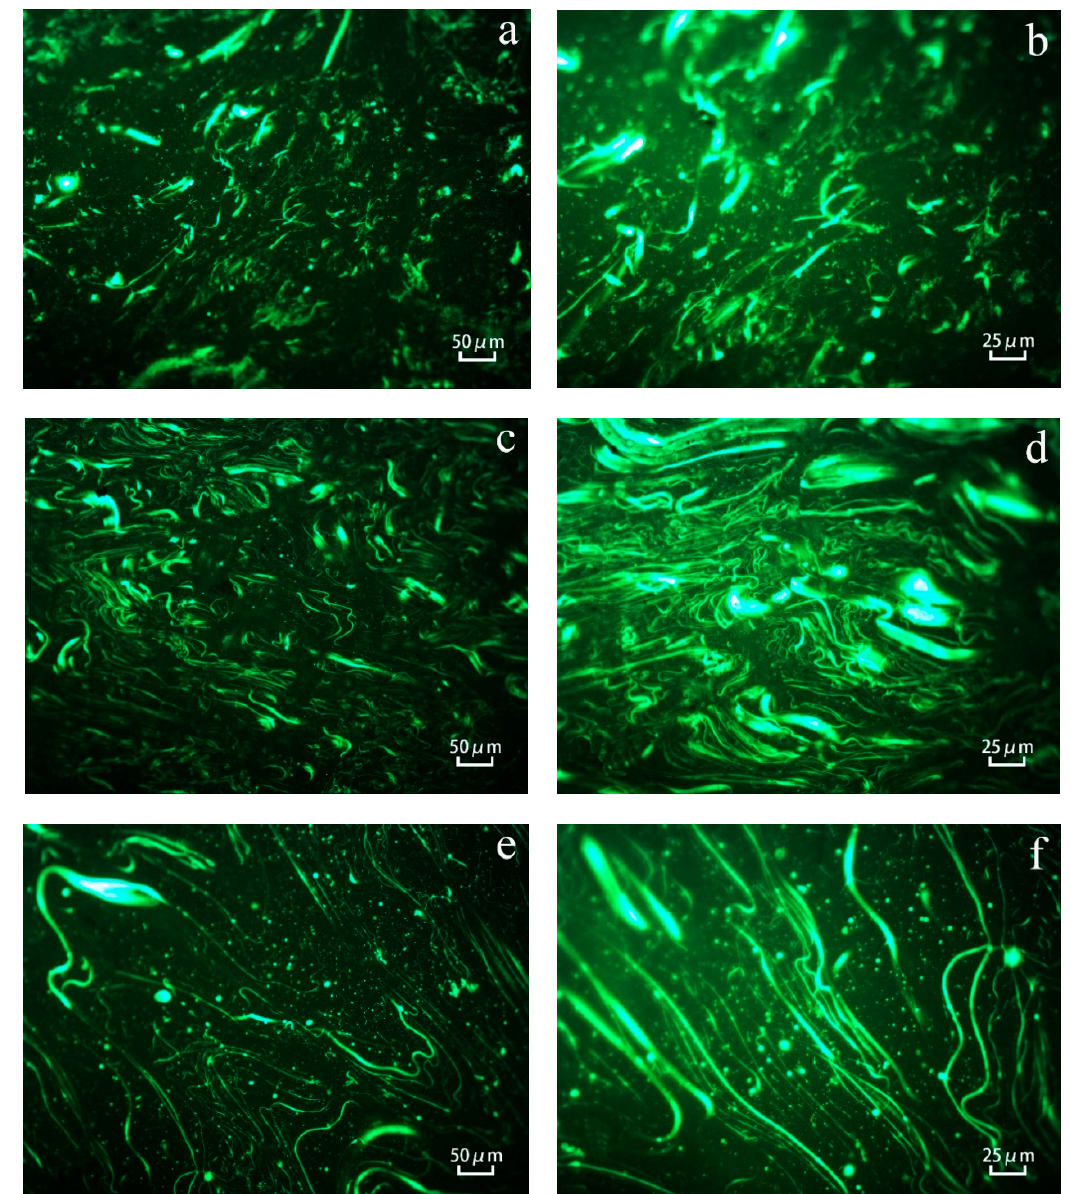
Figure 9. FM images of WRP at 200 × ( a ) and 400 × ( b ); 1-ODA-WRP at 200 × ( c ) and 400 × ( d ); and 3-ODA-WRP at 200 × ( e ) and 400 × ( f ).